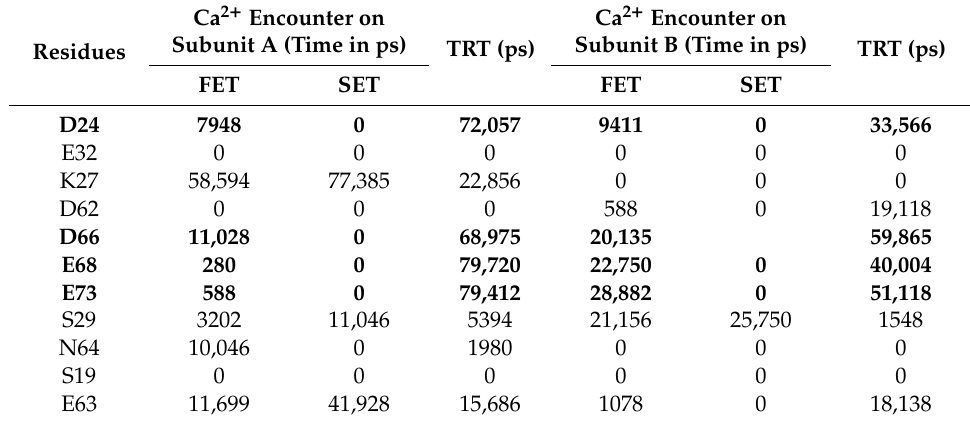
Table 4. The estimation of the total residence time of a Ca 2 + on the corresponding residue whose distance is less than 0.5 nm. The time of primary and secondary encounters of Ca 2 + on the residue is counted. The encounters in bold indicate significant residence